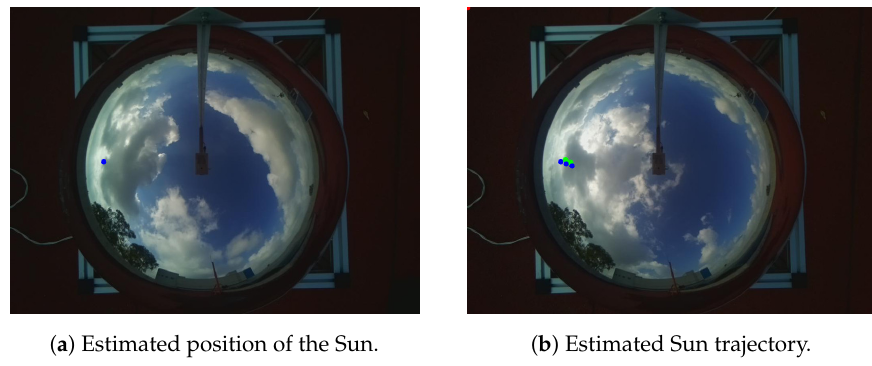
Figure 19. Estimated position of the Sun. ( a ) shows the Sun position estimation at the beginning, and ( b ) shows an example of the trajectory of the Sun given by the Pysolar model (blue dots), as well as the trajectory given by the particle filter (green